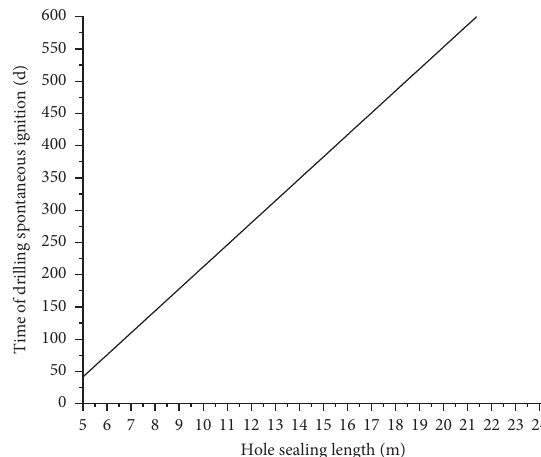
Figure 7: Influence of sealing length on the natural ignition time of